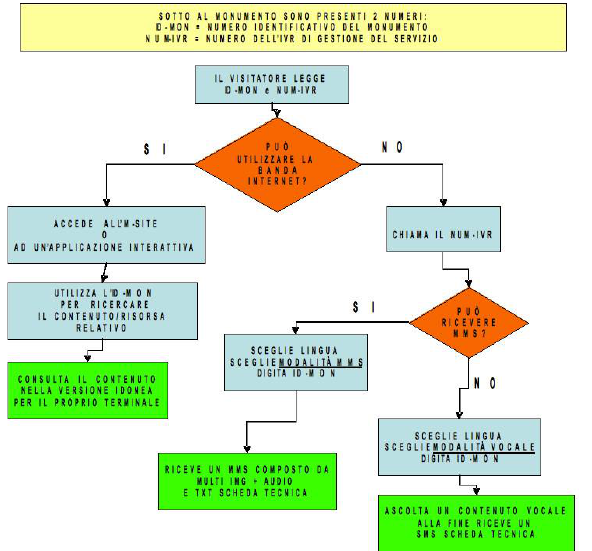
Figure 1. Scheme of the system access possibilities